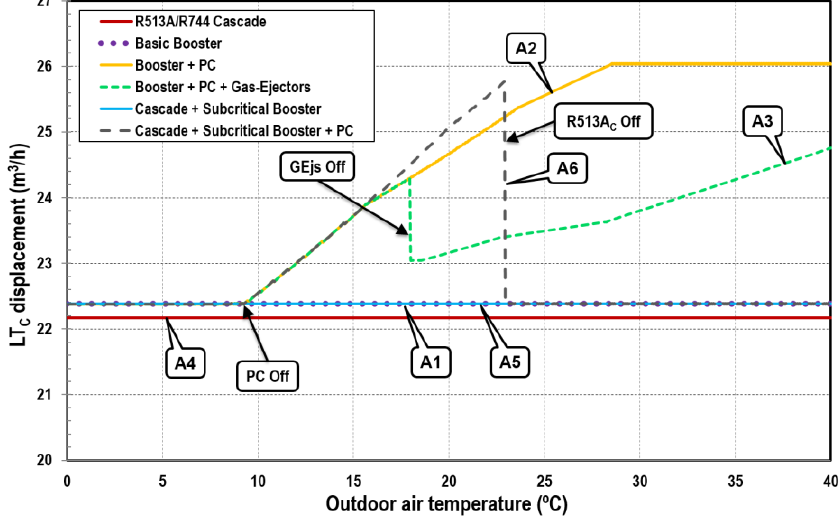
Figure 12. Low temperature compressor displacement.